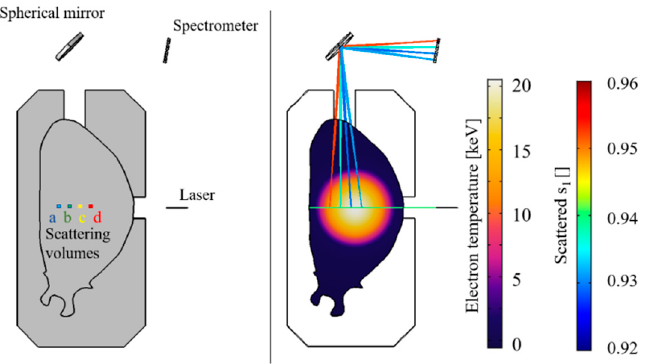
Figure 7. Thomson scattering geometry ( left ); Electron temperatures, ray trajectories of the primary beam (green) and scattered radiation with the first scattered reduced Stokes component s sc,1 ( right ).